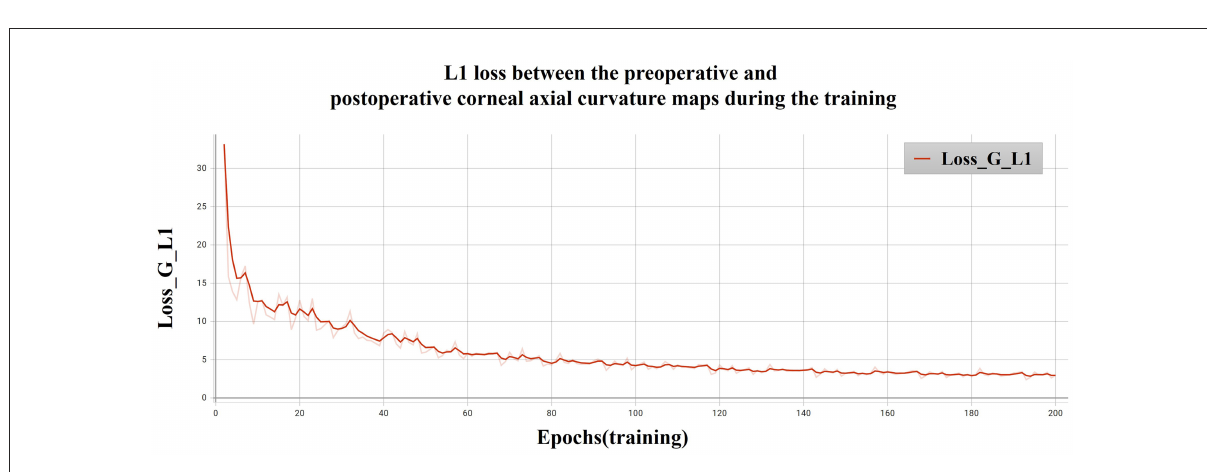
FIGURE8 L1 loss between the preoperative and postoperative corneal axial curvature maps during the training.